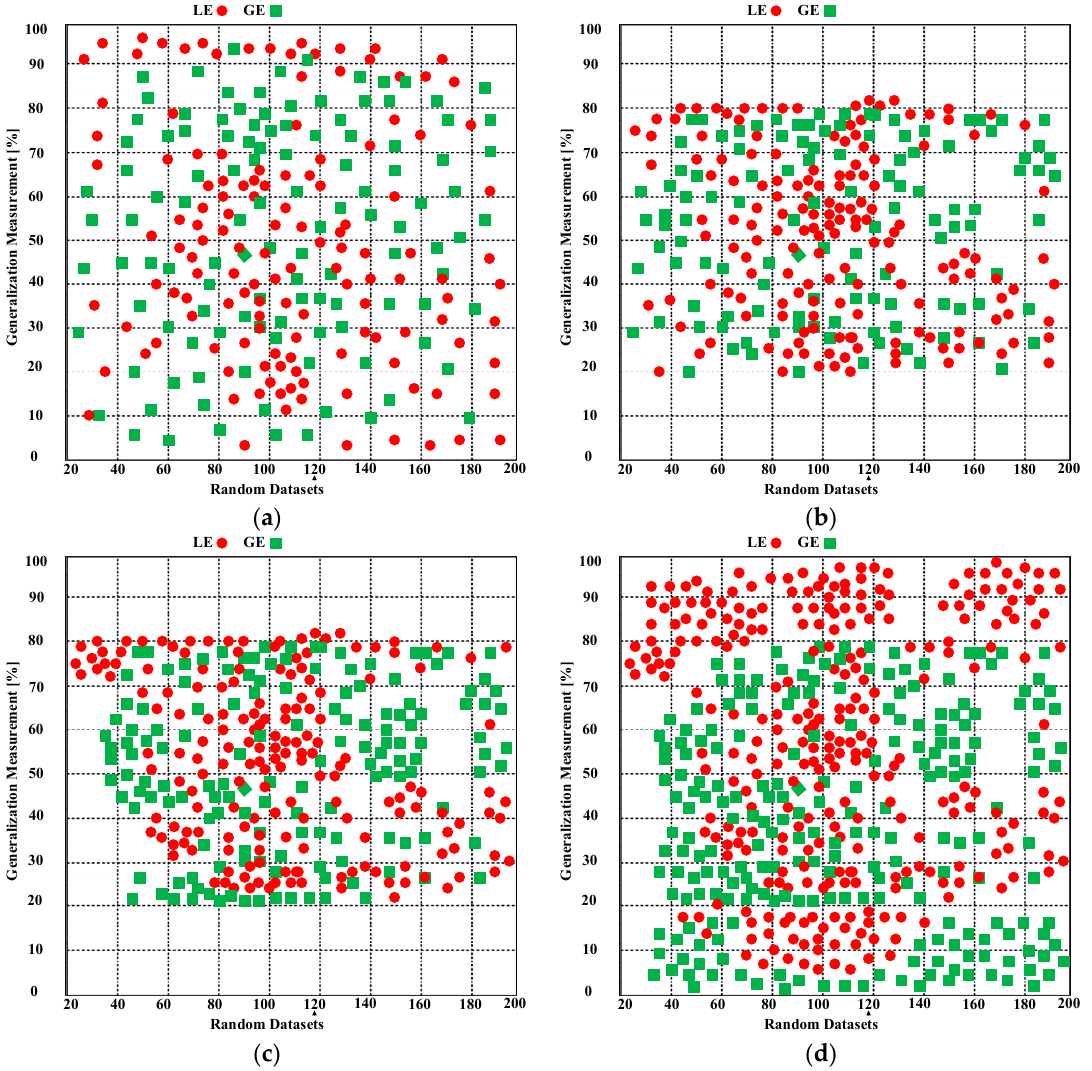
Figure 14. ( a ) demonstrates the generalization process for the random distribution of local and global complex error functions; ( b ) demonstrates the enhanced separation of the two functions (LE and GE); ( c ) demonstrates the self-learning process for the separation of LE and GE; ( d ) demonstrates the optimal separation of both functions and overlapping of LE and GE.